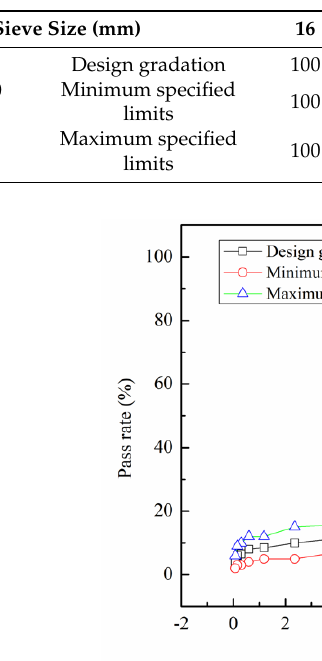
Table 8. Design gradation for base asphalt mixture.